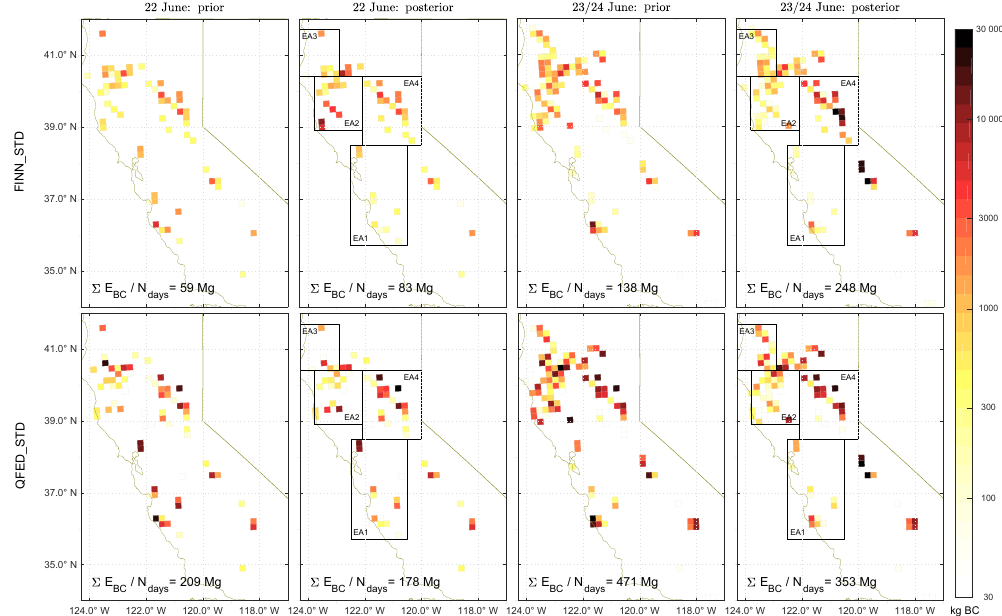
Figure 7. Prior and posterior grid-scale BB emissions of BC per 24h for FINN_STD and QFED_STD on 22 June, 00:00–23:00Z and 23